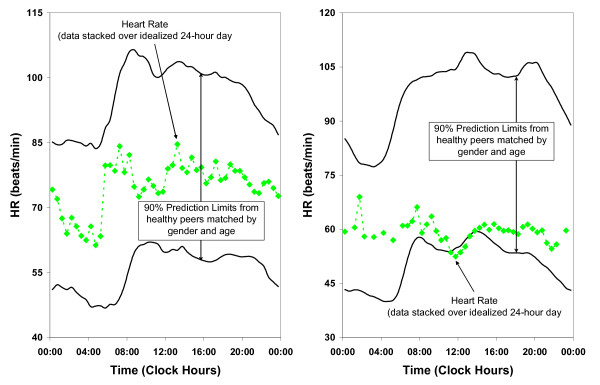
Acceptable and decreased heart rate variability.